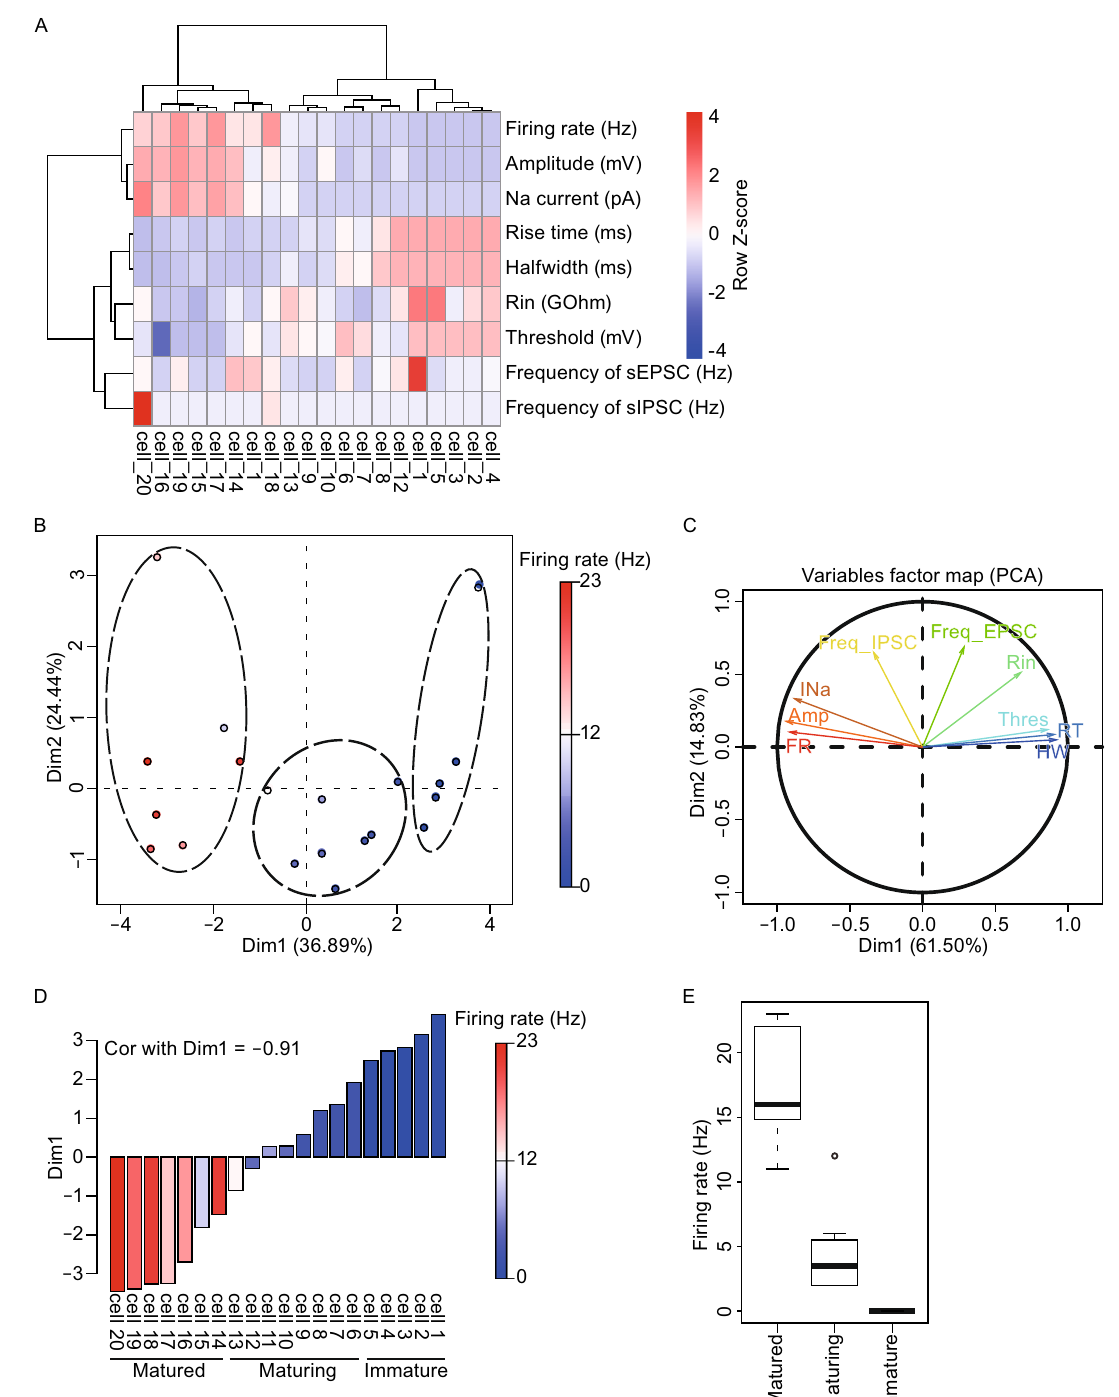
Figure 3. Electrophysiological phenotypes of neurons revealed three groups of neurons based on their maturity. (A) AP and sPSC electrophysiological parameters indicated different maturation stages of 20 single neurons. (B) PCA revealed dimension 1 as an indicationofmaturityandsplit20neuronsintothreegroups.Colorsofeachcirclecorrespondtodifferent fi ringrateoftheneurons,whichis a highly regarded parameter for neuronal maturity. (C) Variable factor map revealed the correlation vector of each electrophysiological parameter with dimension 1 and dimension 2. Arrow tip denotes correlation coef fi cient of the respective parameter with each PC. Abbreviation, Thres. (Threshold); Freq_EPSC. (Frequency of sEPSC); RT. (Rise time); HW. (Halfwidth); Freq_IPSC. (Frequency of sIPSC); INa.(Nacurrent);Amp. (Amplitude); FR.(Firing rate). (D) Highabsolutevalue ofPearsoncorrelationcoef fi cient( − 0.91) between Dim1 and fi ring rate, indicating Dim1 is highly anti-correlated with neuron maturation. (E) Firing rate of three groups of